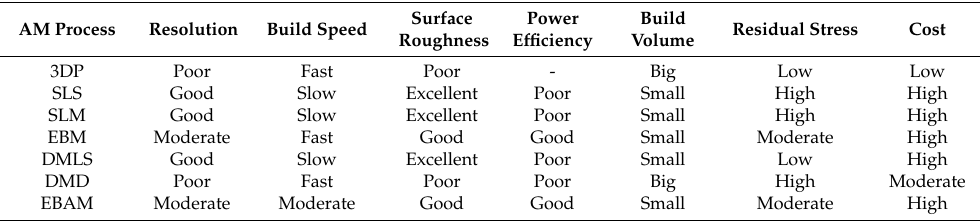
Table 2. Qualitative comparison between different AM